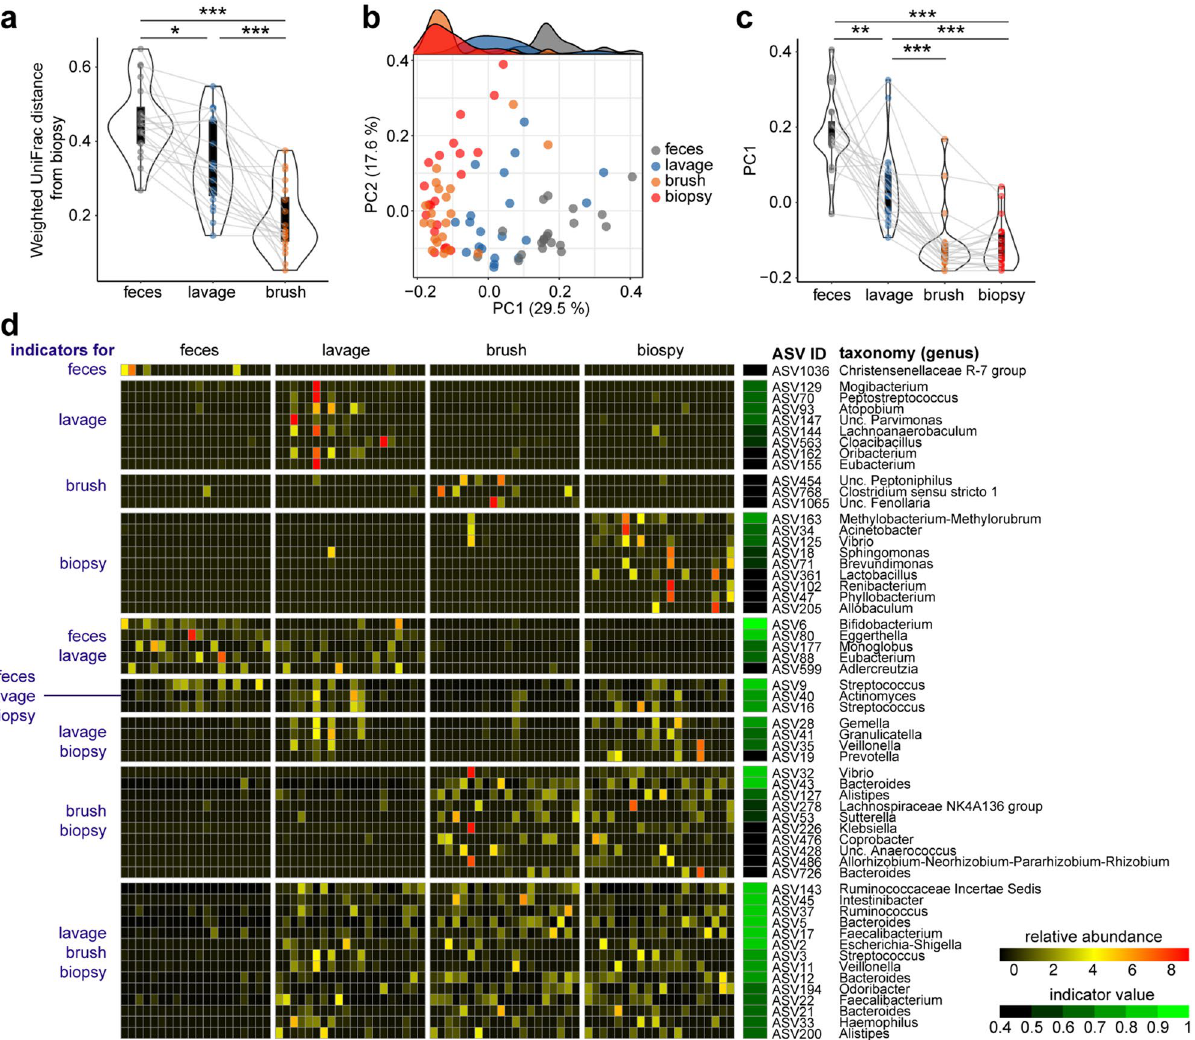
Figure 2. Comparative analysis of bacterial composition in feces and mucosal samples. ( a ) Weighted UniFrac distances from biopsy samples. ( b , c ) PCoA plot of weighted UniFrac distances ( R 2 = 0.26125, p < 0.001, adonis) and the density plot on top shows the sample distribution along the PC1 axis ( b ). The PC1 values of each sample on the plot are summarized in ( c , d ) Heatmap of relative abundance and indicator values of indicator ASVs (FDR-adjusted p < 0.05, indicator value > 0.4). Data represents the mean ± s.d. *** p < 0.001; ** p < 0.01; * p < 0.05; one-way ANOVA with Tukey’s test ( a , c